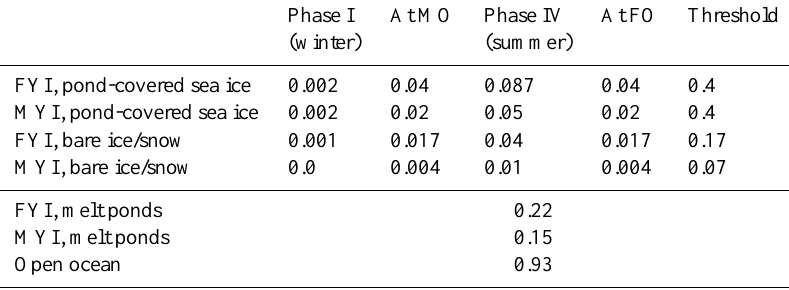
Table 1. Transmittance values of different sea ice and surface types. Abbreviations: FYI: first year ice; MYI: multi-year ice; Phase I: winter; MO: melt onset; Phase IV: summer; FO: freeze onset; Threshold: transition from open ocean to sea ice and vice versa.